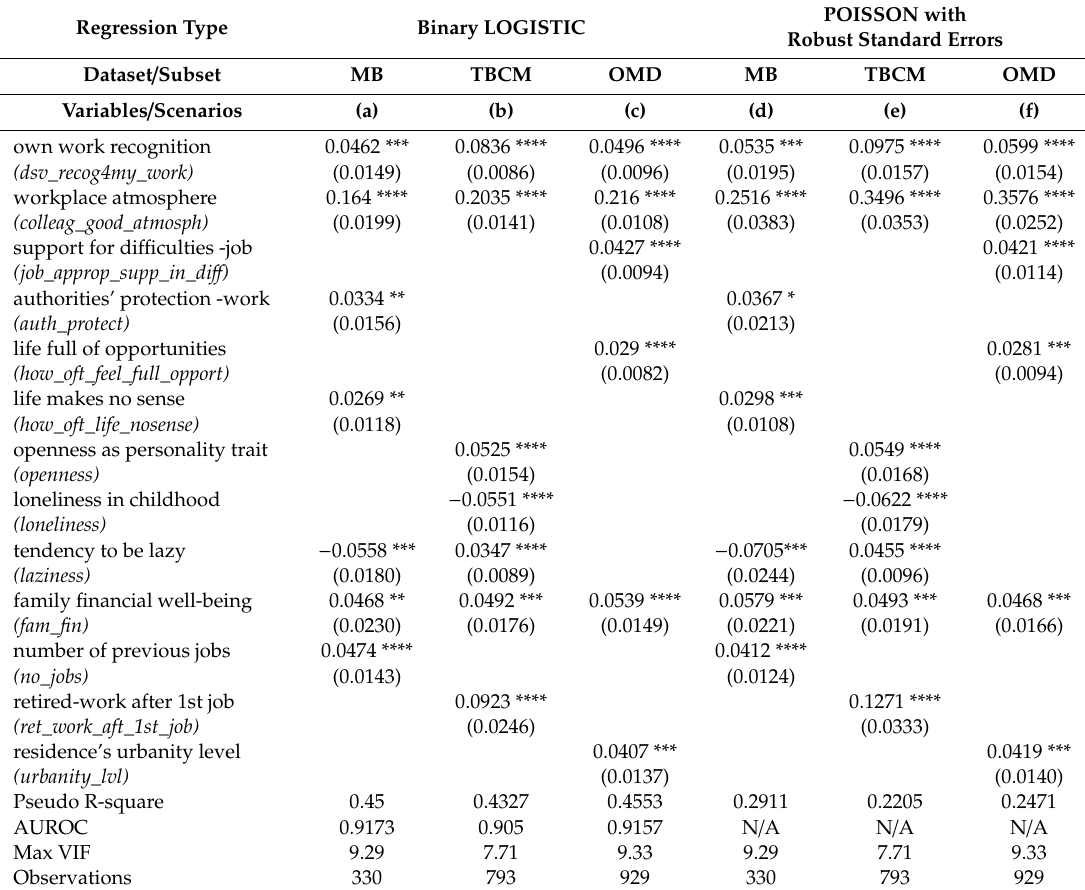
Table 3. Comparable regional models in terms of average marginal e ff ects on full job